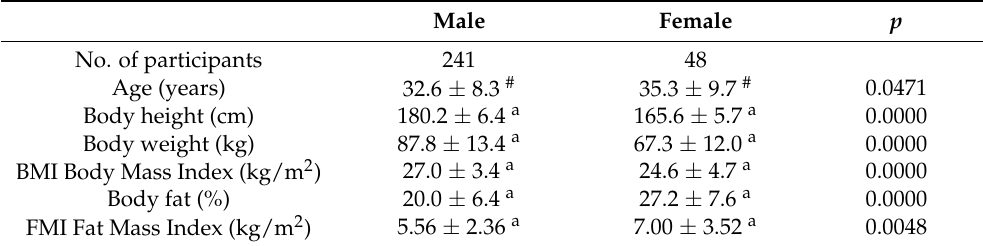
Table 1. Basic characteristics of police officers.